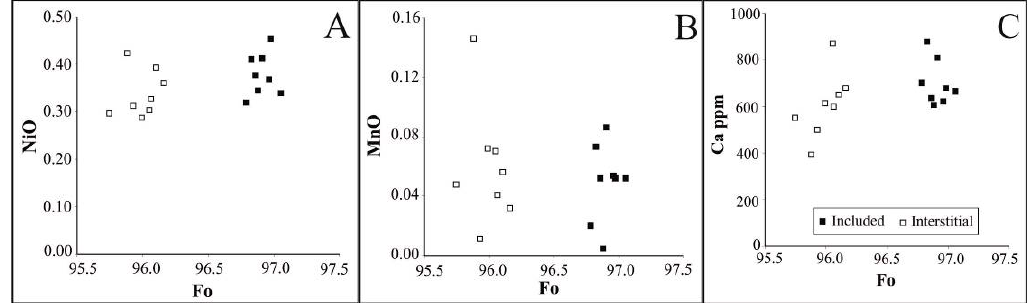
Figure 13. Variation of NiO ( A ), MnO ( B ) and CaO ( C ) as a function of forsterite mol % in the olivine in the Cr-rich chromitites from Kurmanovskoe.